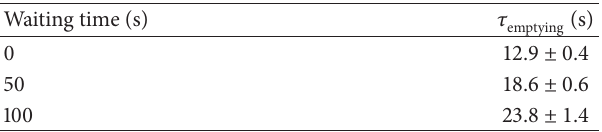
Table 1: Emptying time of UCNs in the source and extraction with two titanium windows for several waiting